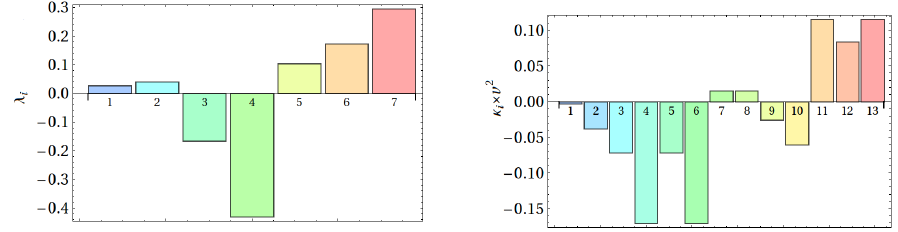
Figure 2. Self-couplings λ i (left) and κ j (right) of the Higgs potential (1)–(4) calculated for the BP1